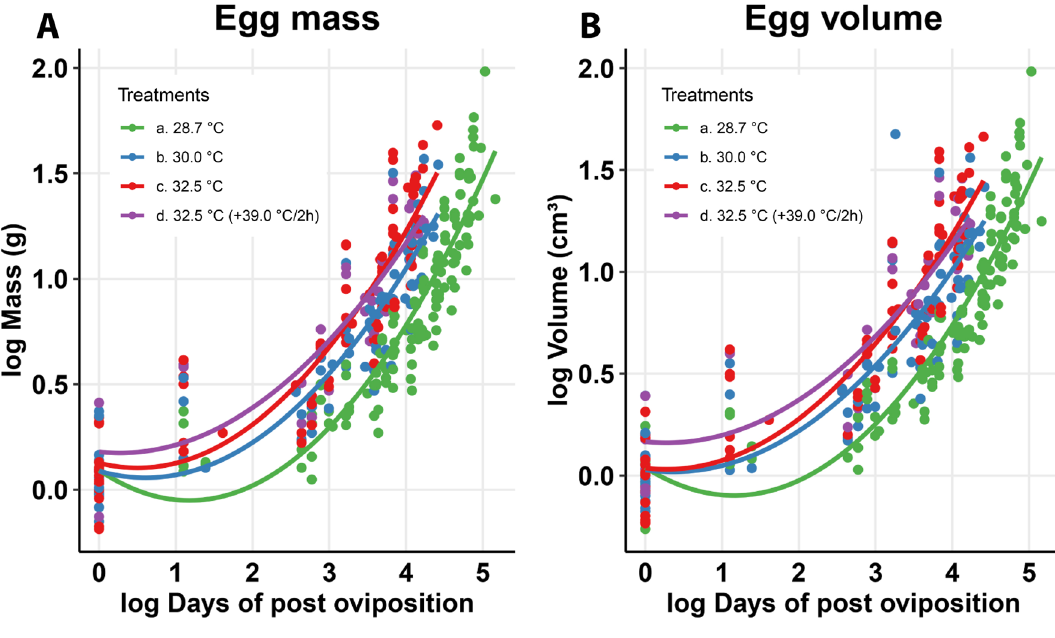
Figure 1. ( A ) Mass and ( B ) volume variation during the incubation of Tropidurus torquatus eggs under four incubation temperature regimes.